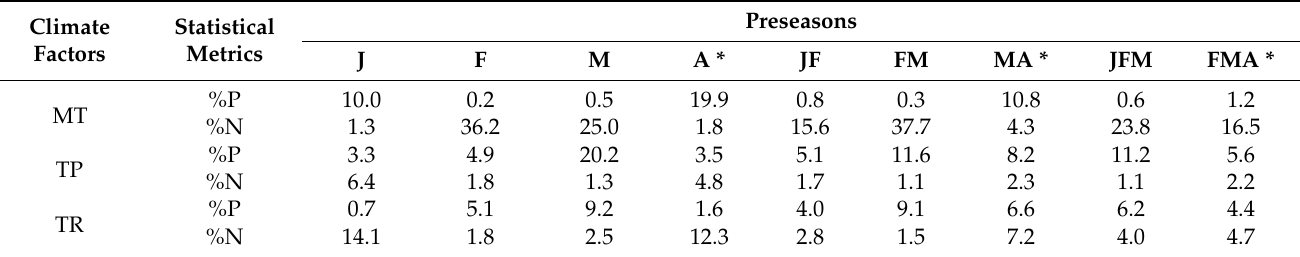
Table 2. Statistics of the Spearman partial correlation coefficients between interannual variations in SOS and climate factors at different preseason lengths. For the climate factors, MT represents mean air temperature; TP, total precipitation; TR, total radiation. In the statistical metrics column, %P and %N represent the percentages of positive and negative correlations ( p < 0.1), respectively. For the preseasons, the abbreviations are the first letters of months. For example, JFM